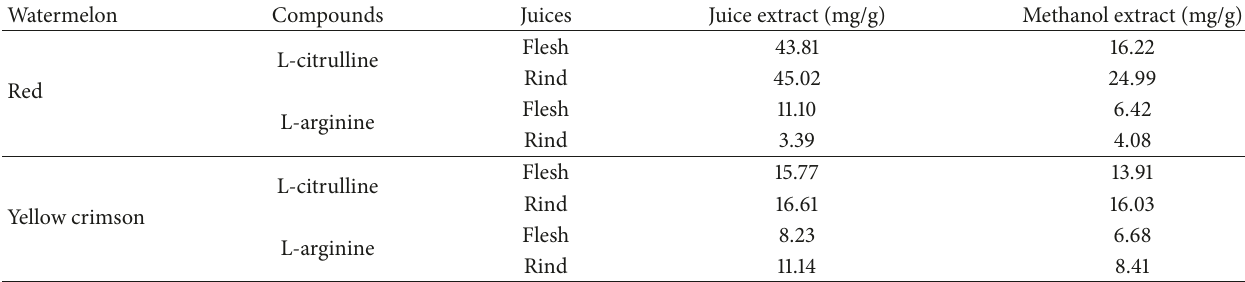
Table 5: L-citrulline and L-arginine contents (mg/g) in juice extract and methanol extract of watermelon flesh and rind juices.